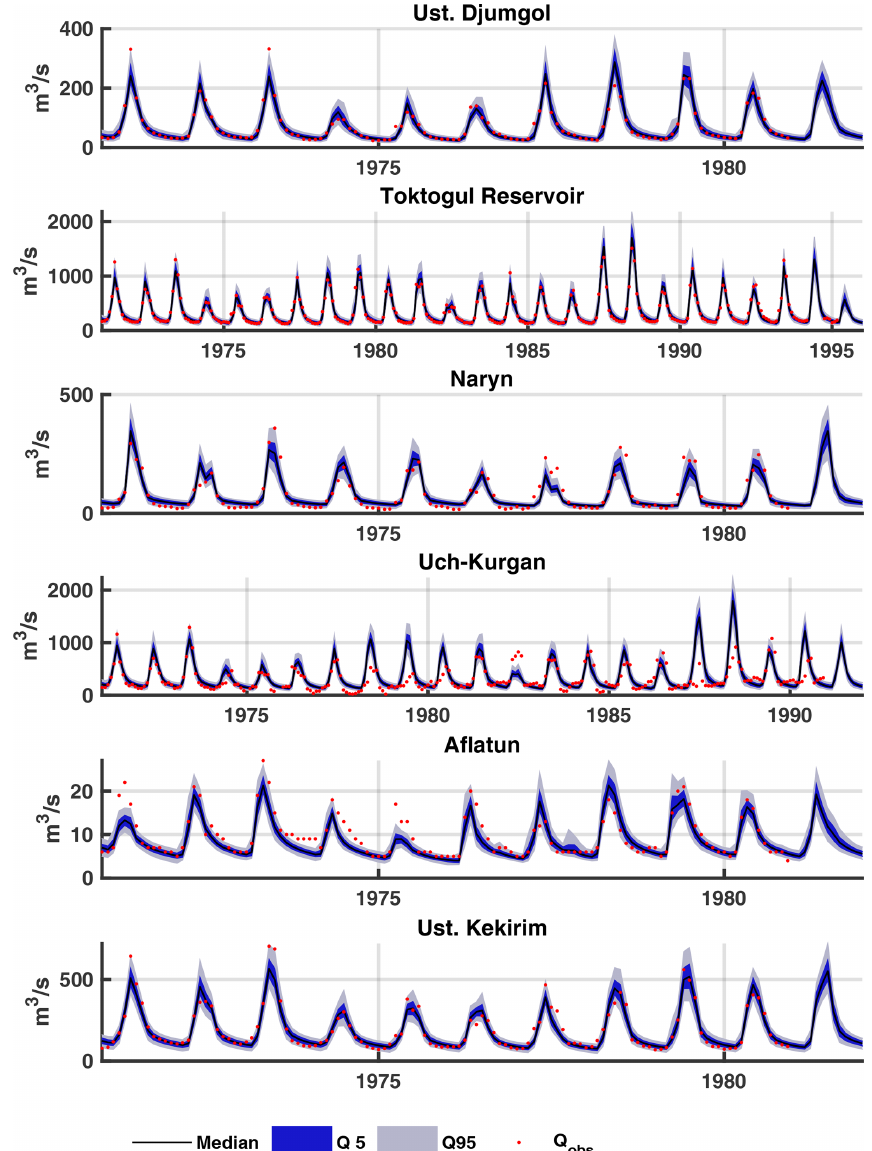
Figure 5. Observed and simulated discharge for the validation period when parameters are selected for individual sub-catchments (MSC method). The shaded envelopes show the 5th–95th percentile ranges and the black line shows the 50th percentile of the best 0.5% simulations.